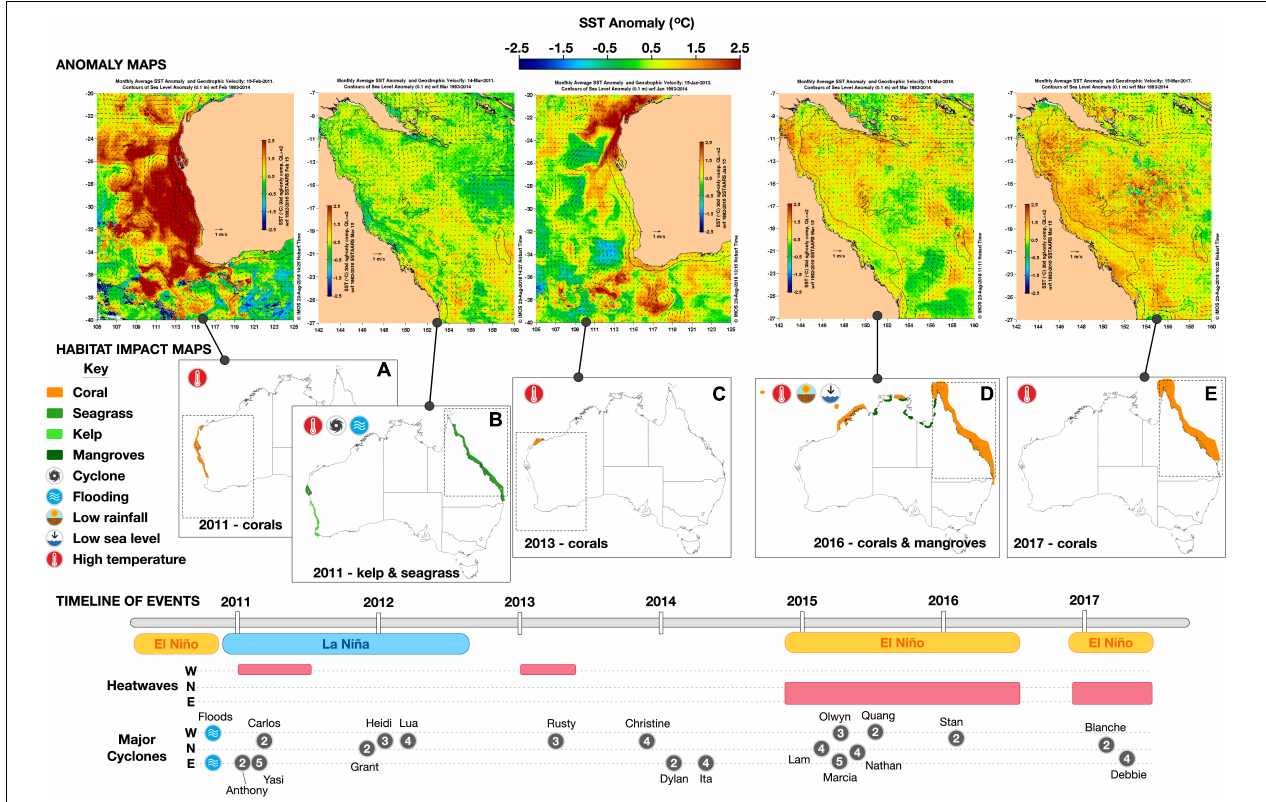
FIGURE 2 | A schematic of the timeline of extreme events and habitat impacts. Sea surface temperature anomaly maps ( ◦ C increase above the monthly climatology over the period 1993–2014) associated with each extreme event are shown, as well as the indicative spatial footprint of the habitat impacts. The maps (A–E) indicate the habitat types affected and the kind of extreme event causing the impact (e.g., MHW, tropical cyclone, flood, etc.), and were created based on maps or geographic details provided in the literature cited in the main text. Thermal anomalies at the time of each ECE are depicted in the figures immediately above. A timeline of the specific types of extreme events are shown in the bottom part of the diagram – with only cyclones (gray circles) of category 2 or above shown (source www.bom.gov.au). W, N, and E indicate the region of Australia (West, North, East) affected.